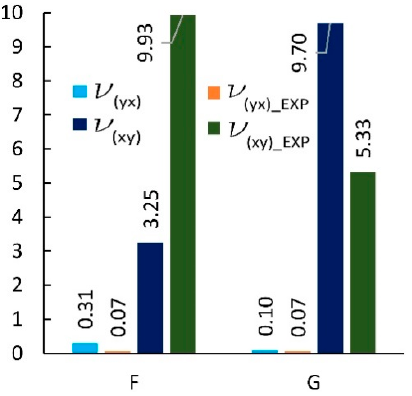
Figure 9. Modulus of linear elasticity for cells of the type: A, B, C, D, E (EXP-experimental research).